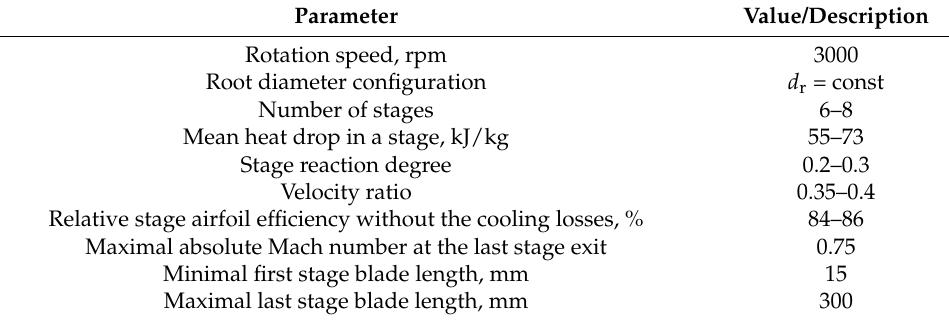
Table 2. Cooled flowpath parameters of the turbine operating on supercritical carbon